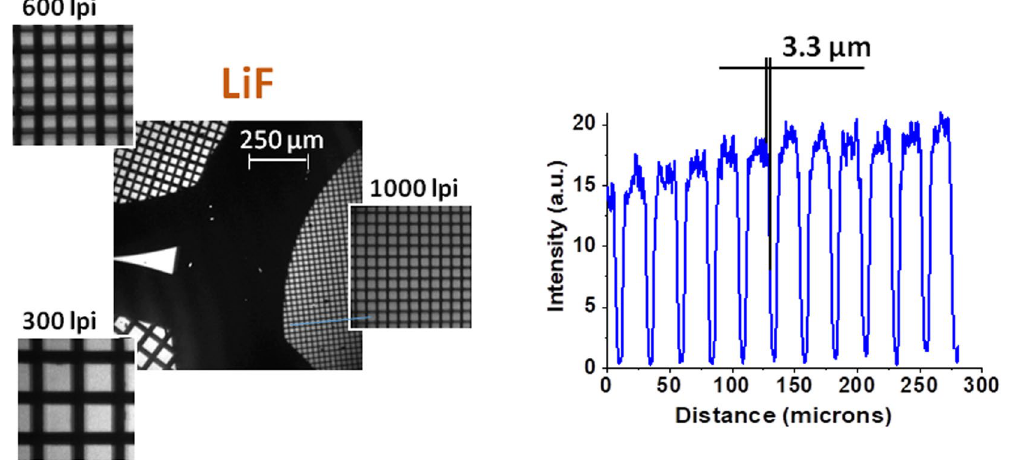
Figure 2. A radiography image of three Au meshes (300, 600 and 1000 lpi respectively), obtained with an LiF detector on one shot of the PICO2000 laser. An intensity profile taken from the lineout of the 1000 lpi mesh is also displayed.